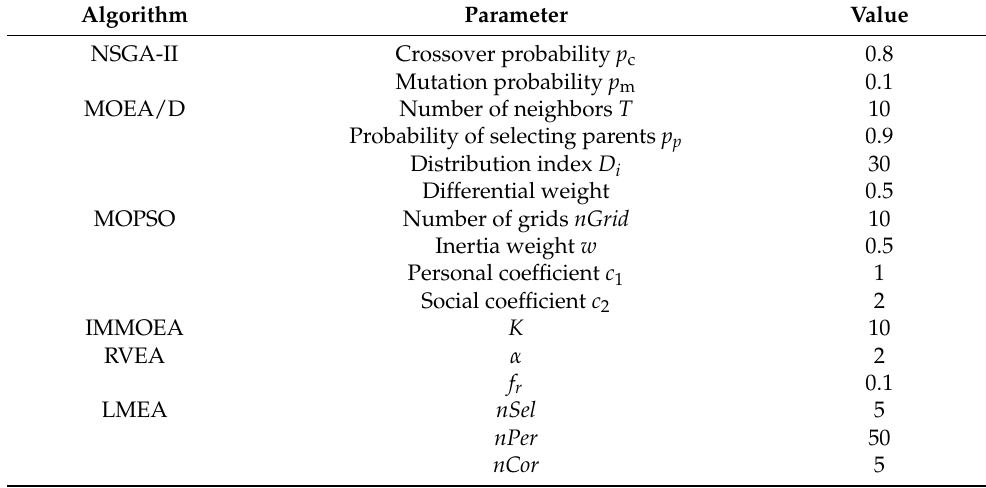
Table 2. Parameters of the algorithms in the